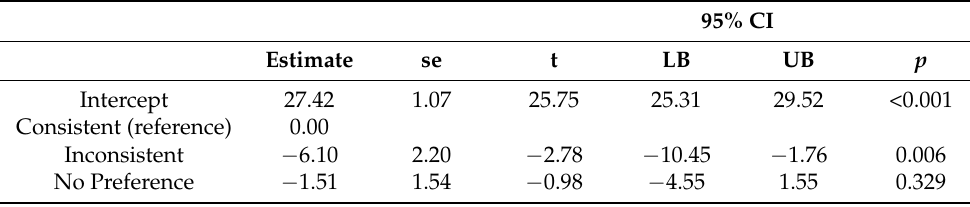
Table 5. Linear regression results for effect of treatment discrepancy on perceptions of